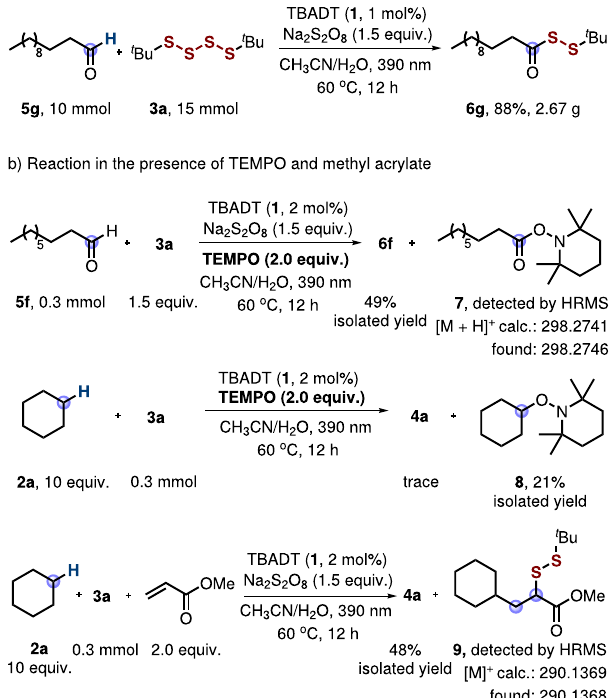
Fig. 6 Gram-scale experiments and mechanistic studies. a Gram-scale preparation of disul fi des 4a and 6 g . b Disulfuration in the presence of TEMPO and methyl